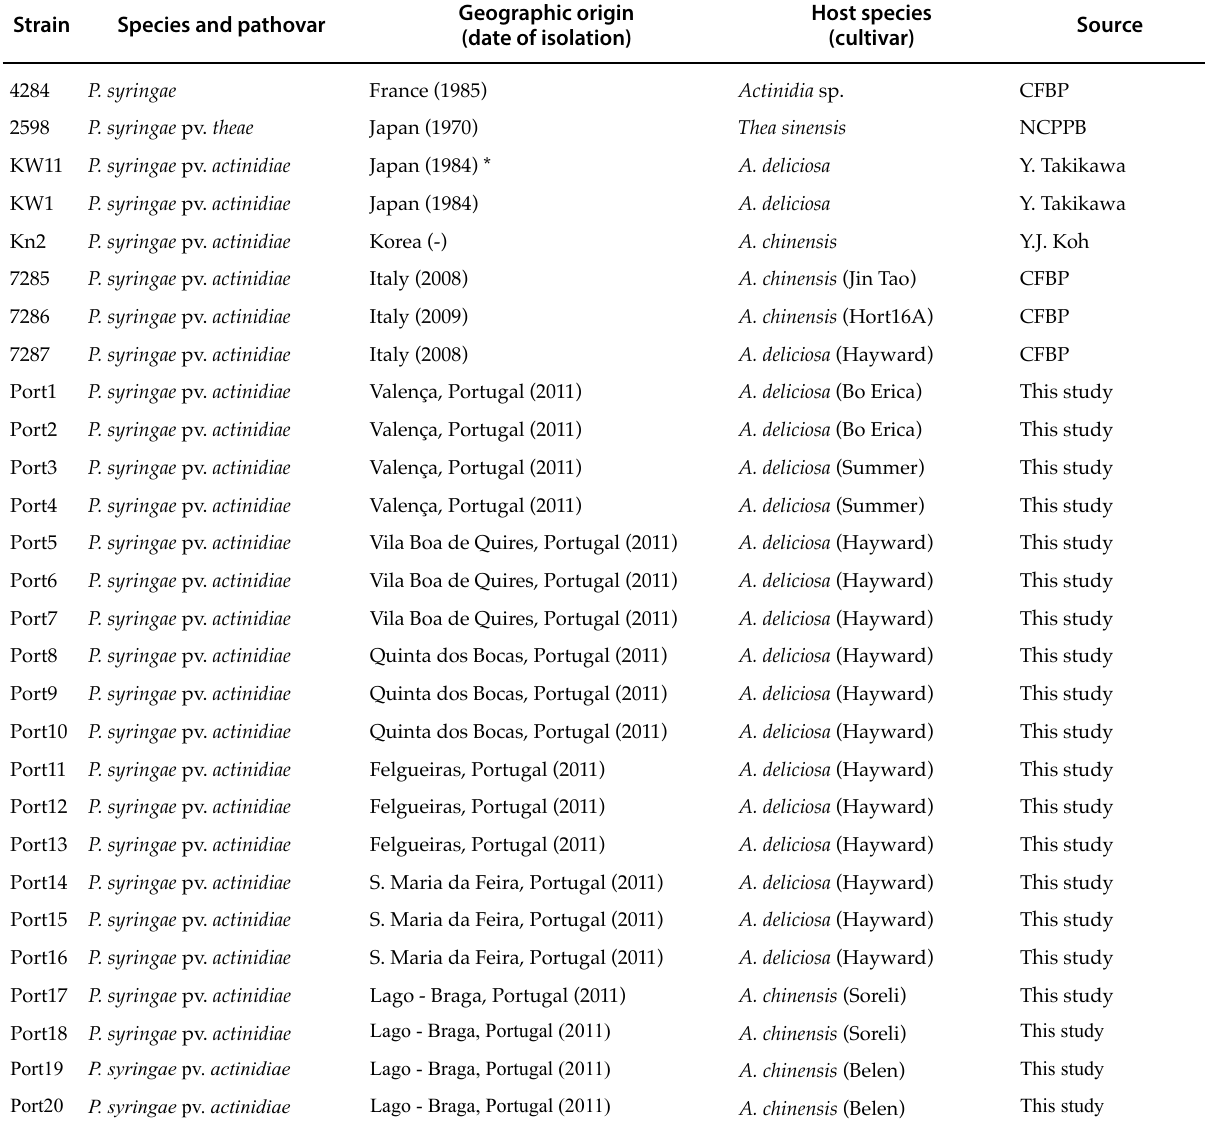
Table 1 . Pseudomonas syringae strains included in the molecular investigations. Strain Species and